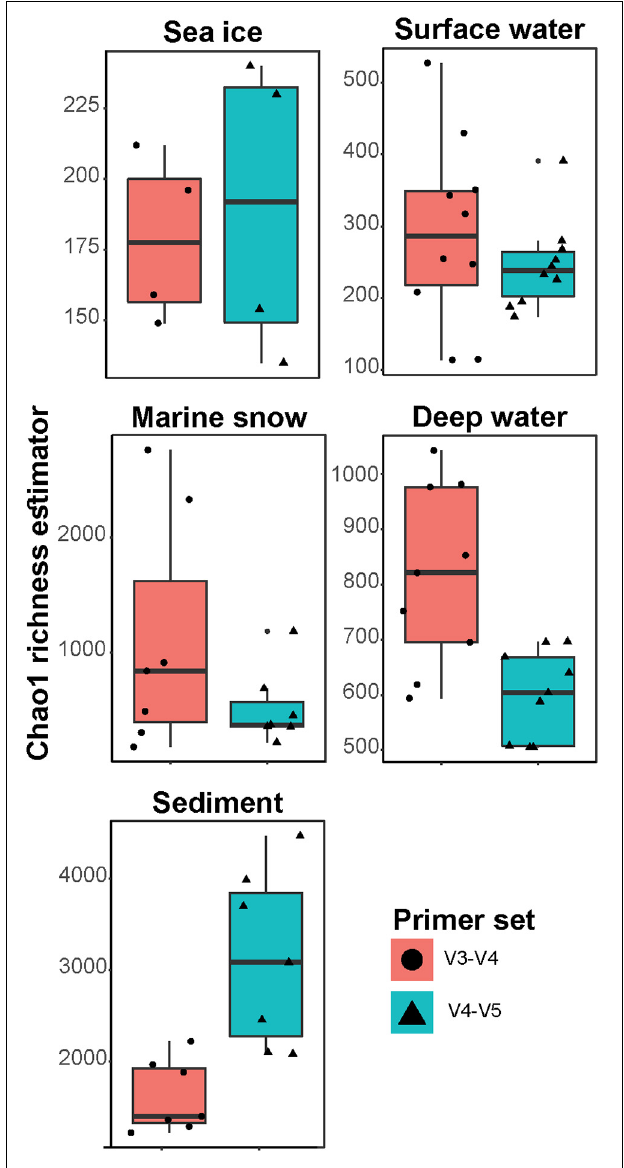
FIGURE 1 | Chao1 richness estimates in the different sample types. Different primer sets represented by colors and shapes. Please note the differences of y -axis between the